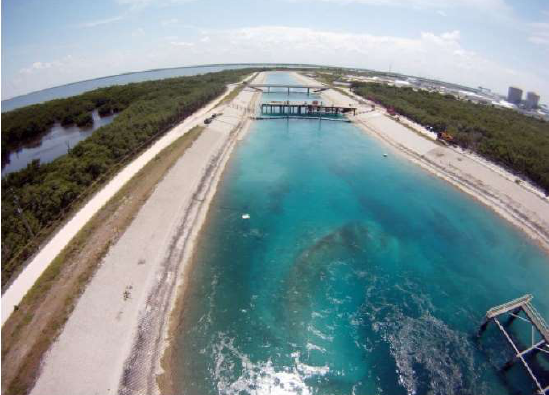
Figure 2. The study site: the entrainment canal at St. Lucie nuclear power plant facility located on south Hutchinson Island, Florida. Permanent mesh barriers are located underneath each bridge, keeping marine fauna in the entrainment at the forefront of the photograph. Photo credit: Serge Aucoin. Table 1. Summary data for goliath grouper deployments at the St. Lucie nuclear power plant facility.